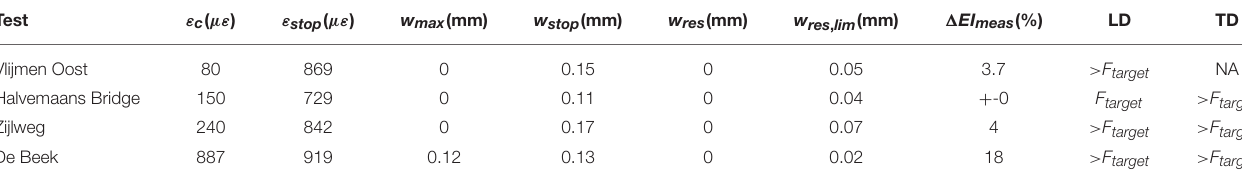
TABLE 9 | Comparison between proposed stop criteria and measurements obtained from pilot proof load tests for flexure.